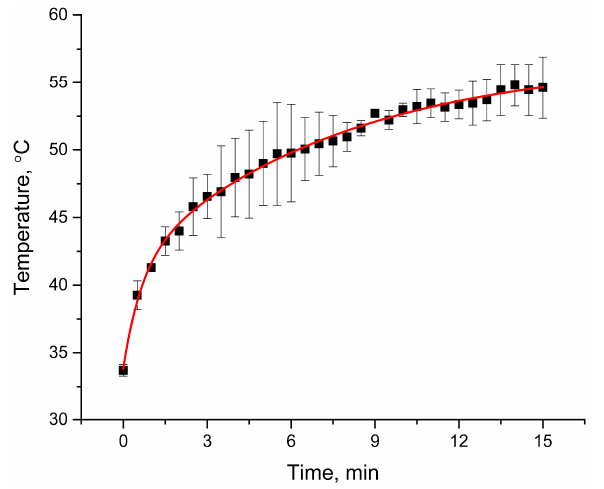
Figure 5. Temperature kinetics of the tissue surface in the experimental group. The symbols correspond to the averaged experimental values with sd, and the solid curve corresponds to the approximation.